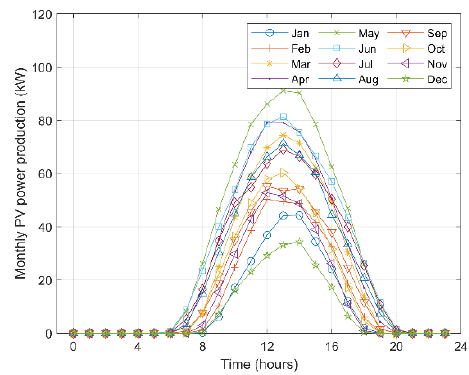
Figure 5. PV power production.